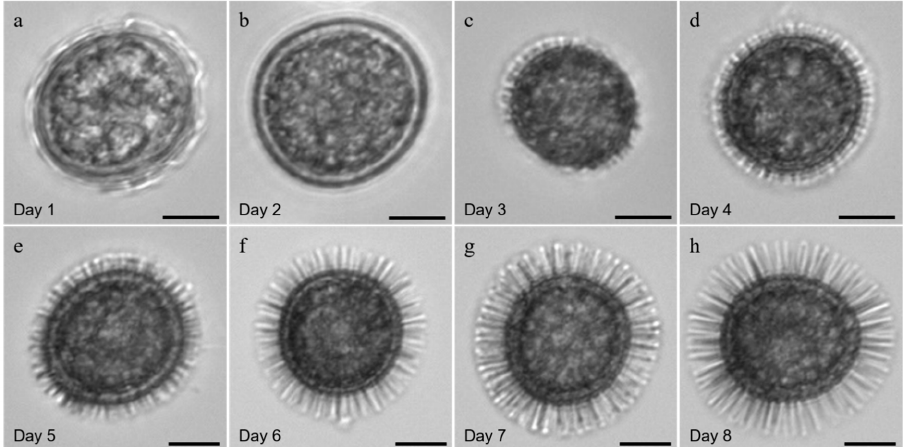
Figure 2. Time series of the formation and changes in the length of calcareous spiny processes of a round Scrippsiella precaria cyst observed in culture LMBE-C28: ( a,b ) round form of the resting cyst, ( c – g ) showing an increase in the length of the spiny processes over time, and ( h ) complete formation of a cyst. Scale bars: 10 µm.